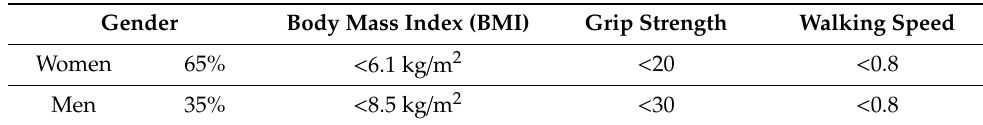
Table 2. Assessment criteria at the Tijuana General